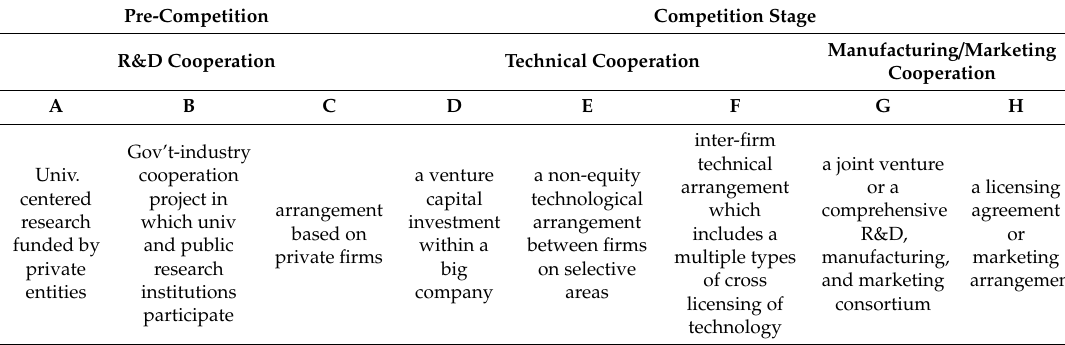
Table 1. Stages of technology development